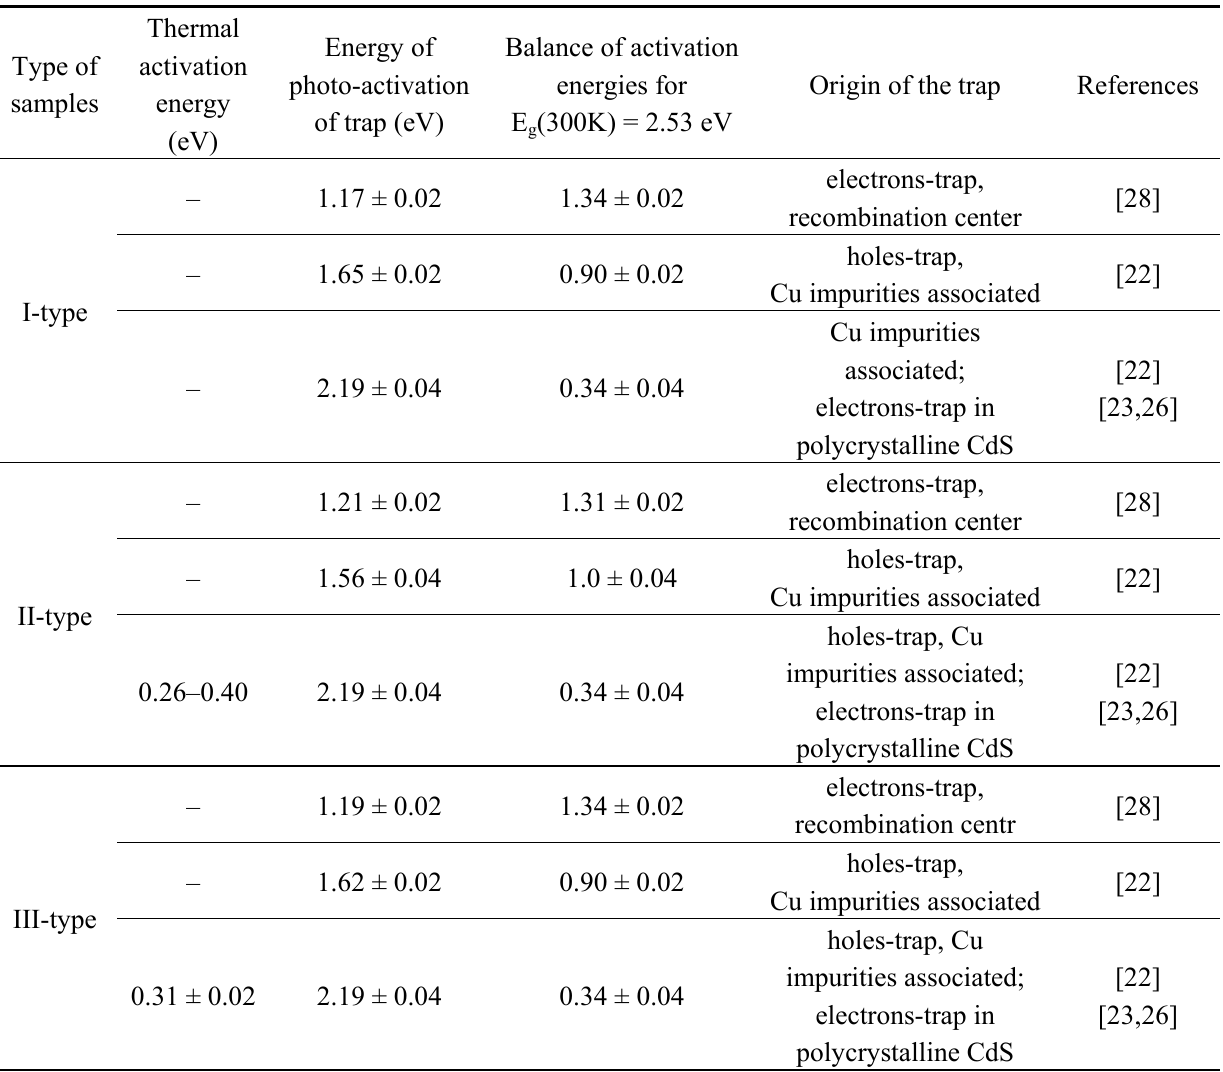
Table 3. Correlation of PIS peaks with deep level transient spectroscopy (DLTS) peaks obtained within spectra of different types of